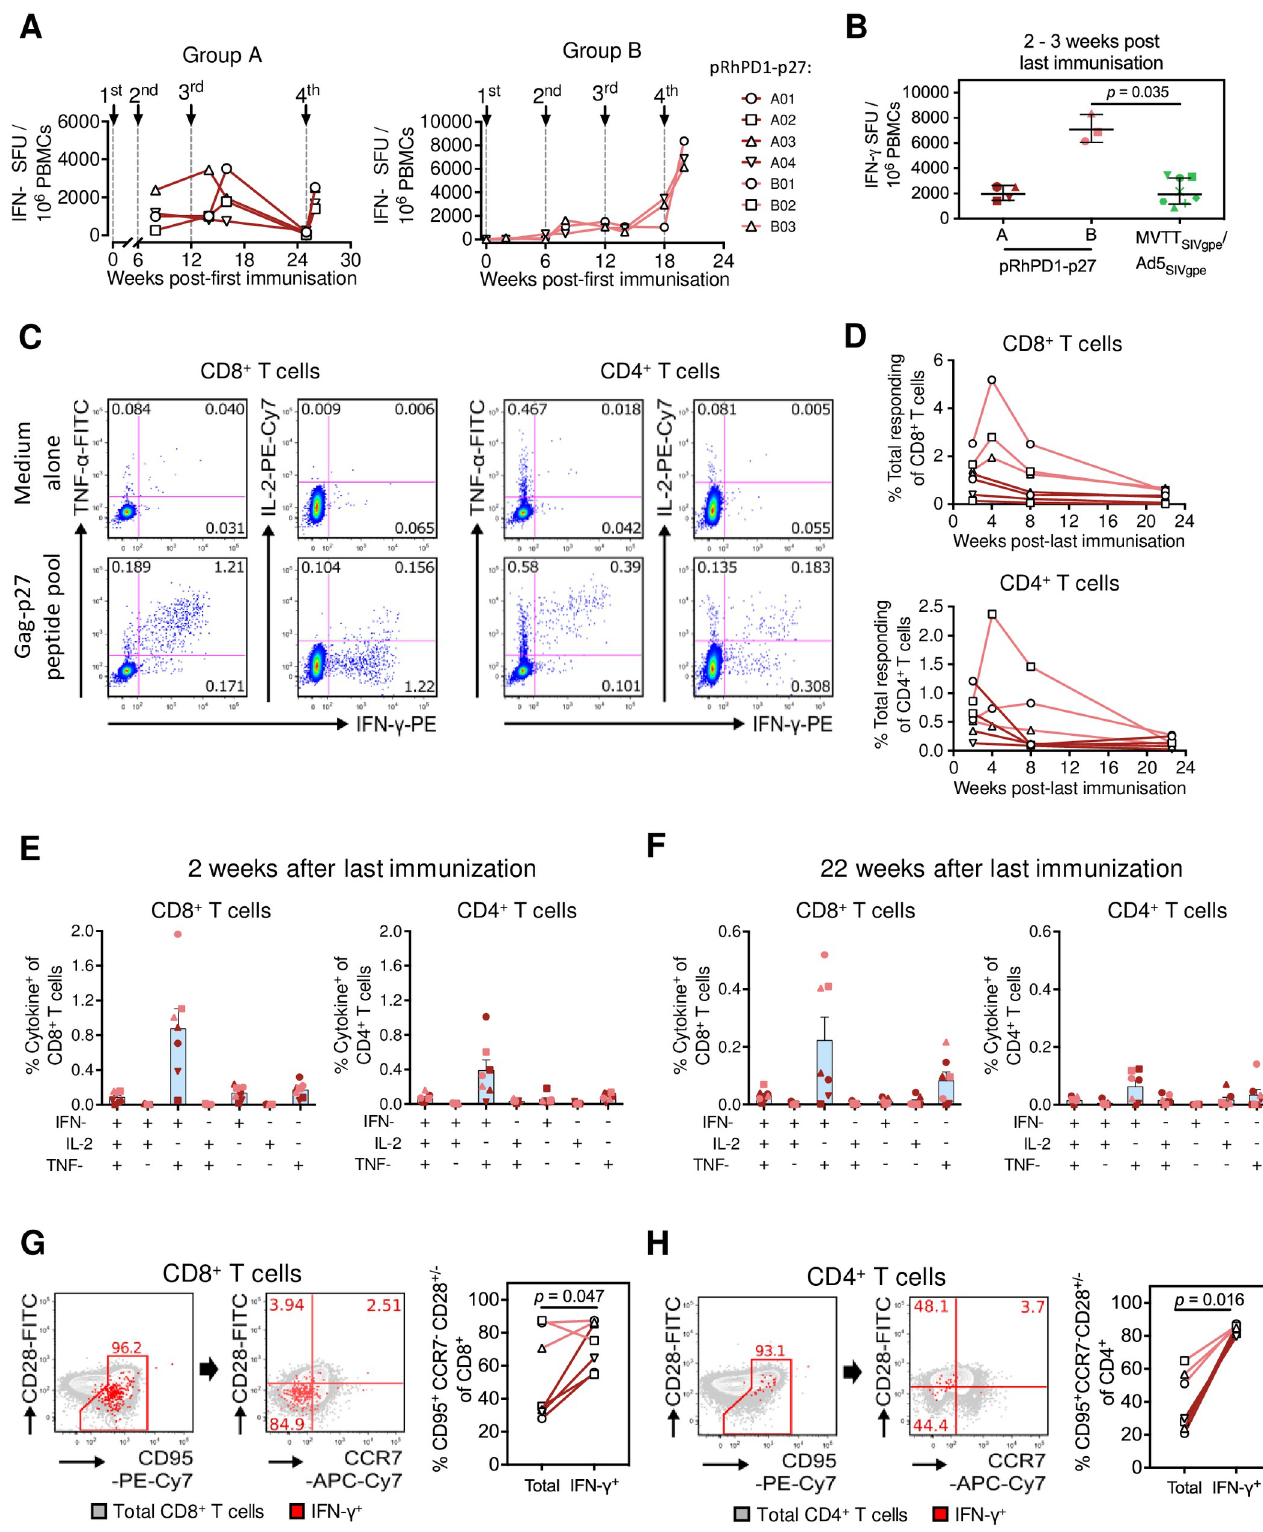
Fig 3. T cell immunogenicity of the pRhPD1-p27 vaccine in rhesus macaques. (A) Kinetics of p27-specific cellular immune responses in peripheral blood measured by IFN- γ ELISpot. (B) Comparison of ELISpot-detected p27-specific T cell responses induced in Groups A and B by the pRhPD1-p27 vaccine